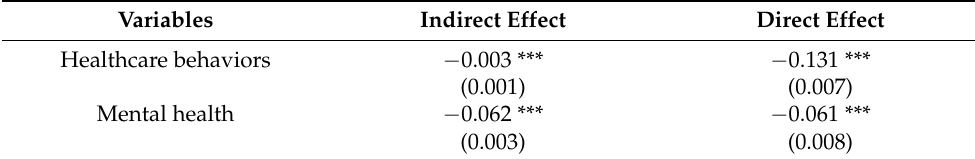
Table 6. Intermediary mechanism test.